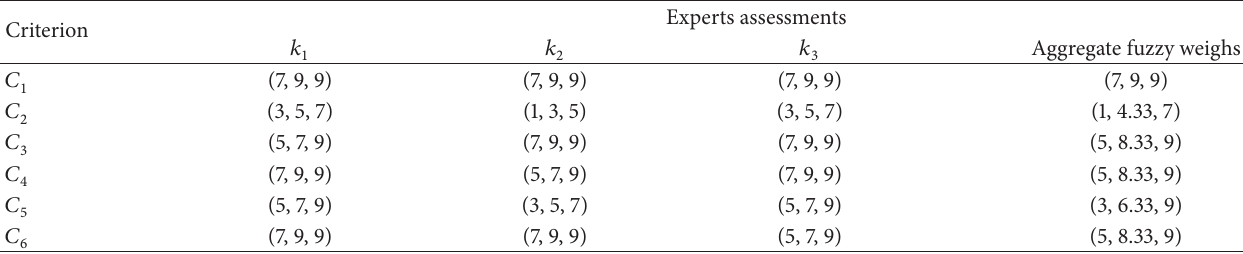
Table 8: The aggregate fuzzy weights of each criterion.